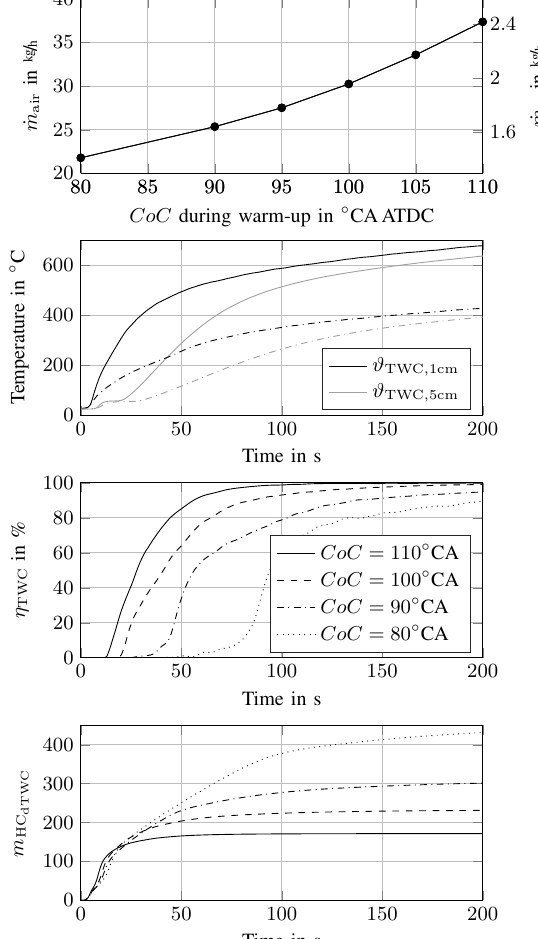
Figure 8. Influence of the center of combustion on the engine and catalyst behavior during the warm-up phase. In the second plot from the top, the temperatures are shown for the cases CoC = 110 ◦ CAATDC and CoC = 90 ◦ CAATDC only for better